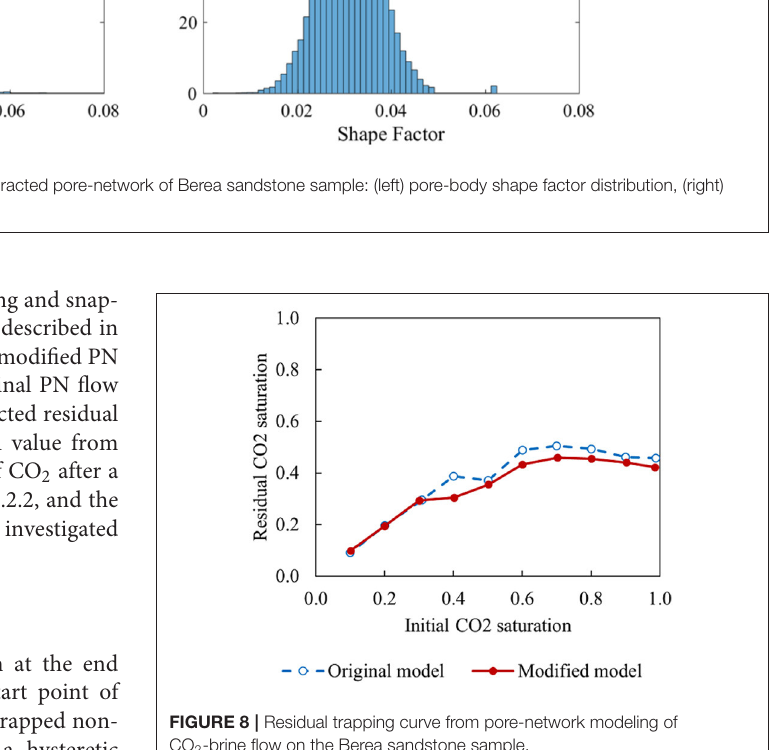
FIGURE 8 | Residual trapping curve from pore-network modeling of CO 2 -brine flow on the Berea sandstone